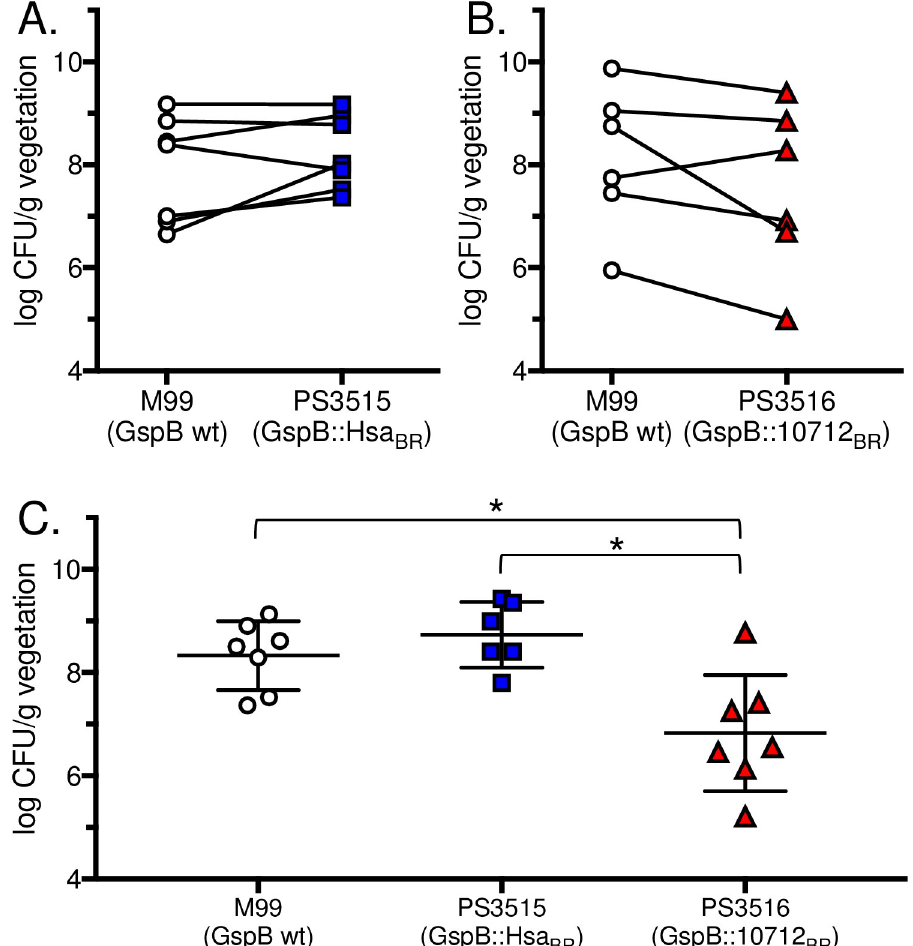
Fig 5. Relative virulence of S . gordonii M99 and the isogenic variant strains in two rat models of endocarditis. Animals were infected with 10 5 CFU of each of a pair of strains (A and B; n = 7 and n = 6, respectively) or with 10 5 CFU of a single strain (C; n = 7 for M99, n = 6 for PS3515 and n = 7 for PS3516). The number of bacteria in aortic valve vegetations was assessed 72 h post-infection. Asterisks indicate p < 0.05. https://doi.org/10.1371/journal.ppat.1007896.g005 level (Fig 6C and 6D). These results indicate that binding of bacteria to sLn rather than sTa (PS3516 versus M99) results in diminished initial colonization. The lower extent of initial colo- nization does not fully account for the reduced numbers of PS3516 seen at 72 h, since the